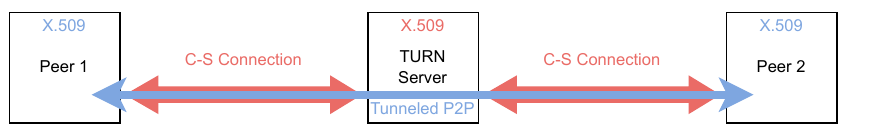
Figure A1. Peer 1 and Peer 2 establish a mutual TLS connection peer-to-peer (blue) through two separate Client-Server TLS connections (red) via the TURN